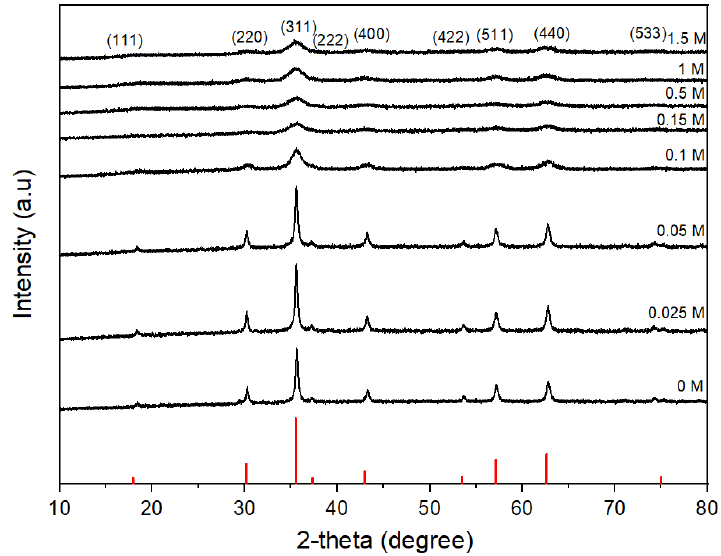
Figure 9. XRD patterns of cobalt ferrite nanoparticles synthesized at 180 °C, 16 h with different oleic acid concentrations.